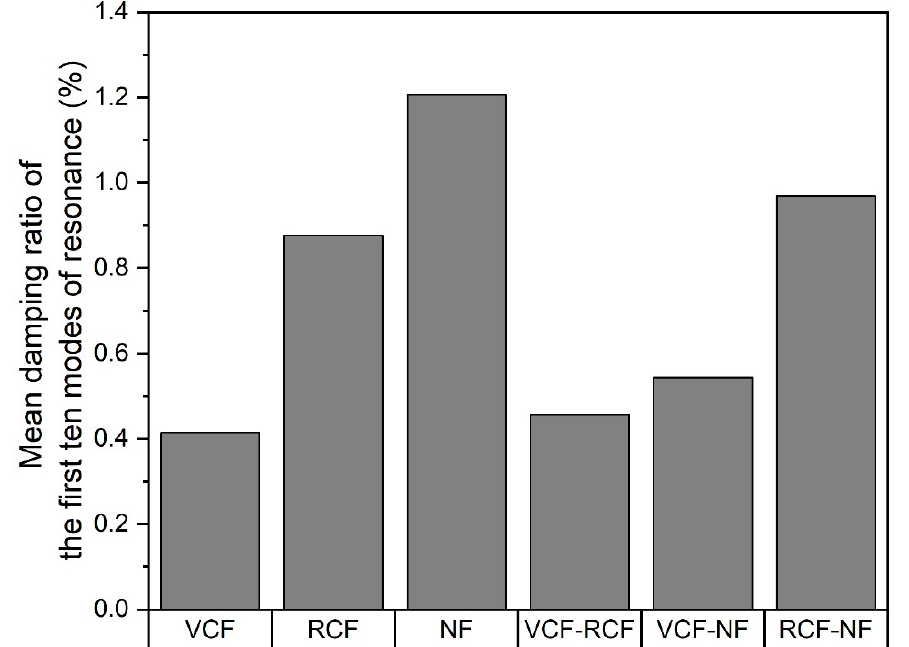
Figure 8. Mean damping ratio of the first ten modes of resonance by reinforcement material.